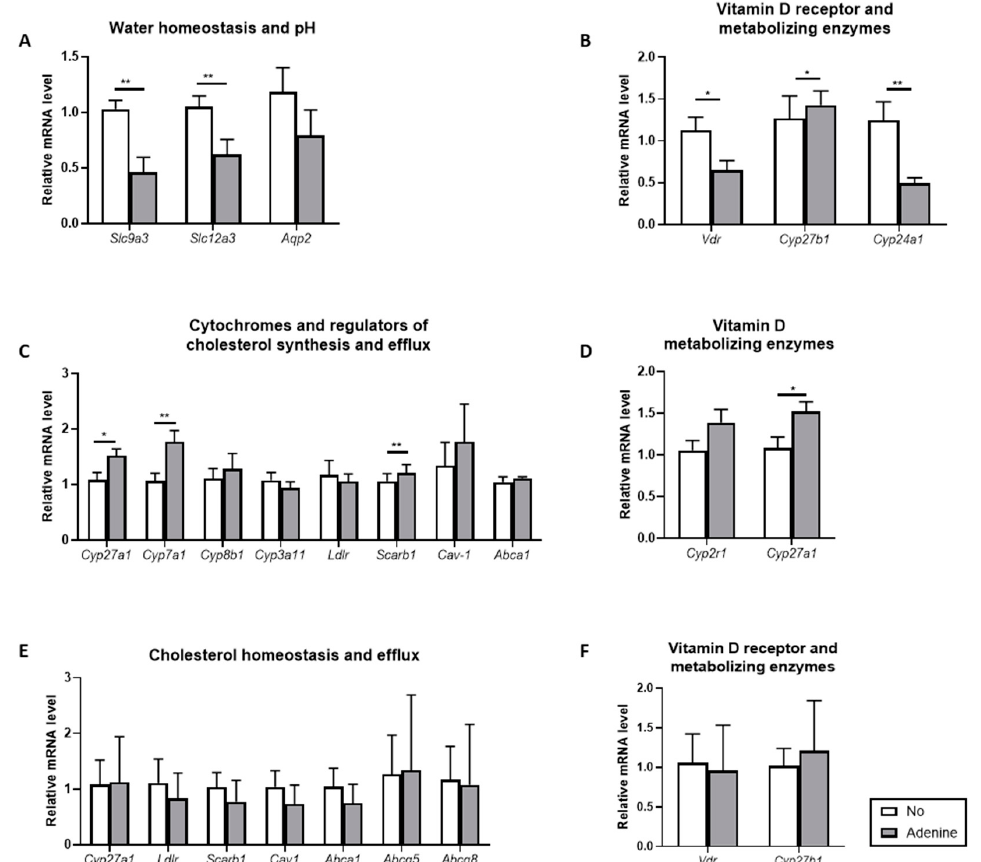
Figure 5. Adenine-induced effects on gene expression in the kidney and liver. ( A ) Expression of genes involved in Na + transport and pH; ( B ) vitamin D receptor and vitamin D metabolizing enzymes were assessed in kidney tissues; ( C ) similarly, gene expression of genes accounting for cytochromes, regulators of cholesterol synthesis, and RCT, as well as ( D ) vitamin D metabolizing enzyme were investigated in the liver. ( E ) Expression of genes involved in cholesterol homeostasis and ( F ) vitamin D receptor and vitamin D metabolizing enzymes in the colon. B-actin was used as a housekeeping gene. NO represents the control group fed with WD-CAC. Results are presented as means ± SEM ( n = 8–11). For statistical difference, * p < 0.05, ** p < 0.01.